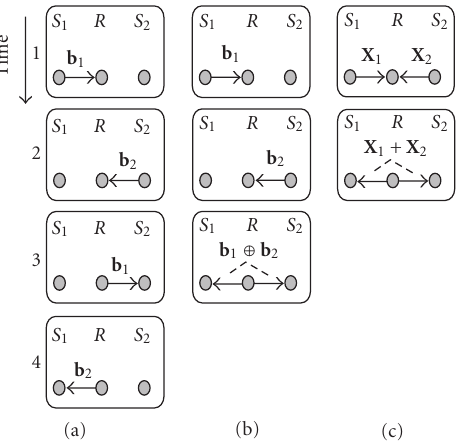
Figure 1: Bidirectional communication protocols: (a) 4-phase conventional protocol, (b) 3-phase protocol with decode-and- forward network coding, and (c) 2-phase BAF protocol with amplify-and-forward